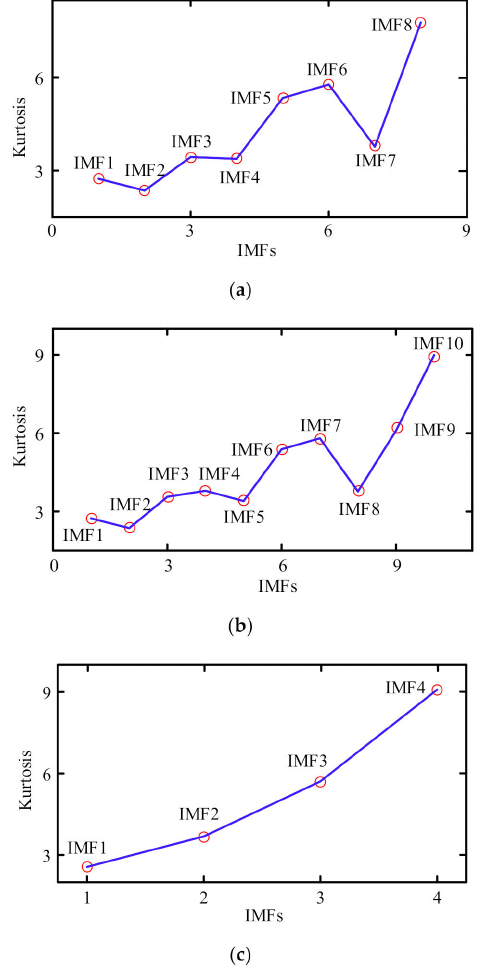
Figure 7. Kurtosis diagram of IMF components of original time series. ( a ) Kurtosis diagram of